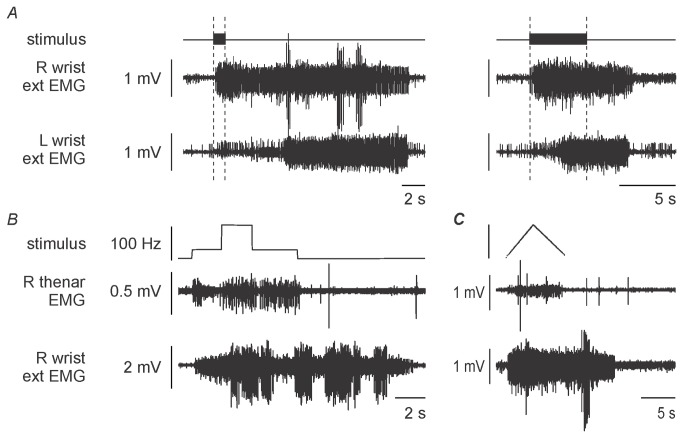
Stimulus protocols.A: Stimulus train duration. The greatest responses, both in duration and magnitude, were obtained with trains lasting 1 s. Longer train durations (right) commonly curtailed the self-sustained activity in all muscles studied. Note the consistently later response in the left wrist extensors. Dashed vertical lines indicate the duration of the stimulus trains. B–C: Responses to different stimulus patterns (see refs 14,16). Self-sustained activity was evident in the right wrist extensors with both stimulus patterns, but not in the right thenar muscles. A: 25 Hz for 2 s then 100 Hz for 2 s then 25 Hz for 3 s, C: ramp stimulus, increasing from 1 Hz to 100 Hz over 5 s and then decreasing to 1 Hz over 5 s.